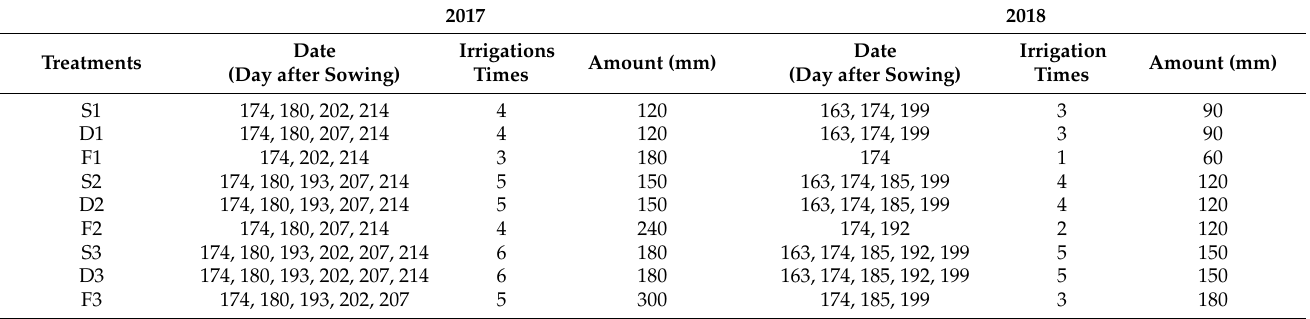
Figure 1. The field experimental design layout and treatment arrangement. Table 1. Irrigation date, number of irrigations, and irrigation amount for all treatments in 2017 and 2018.